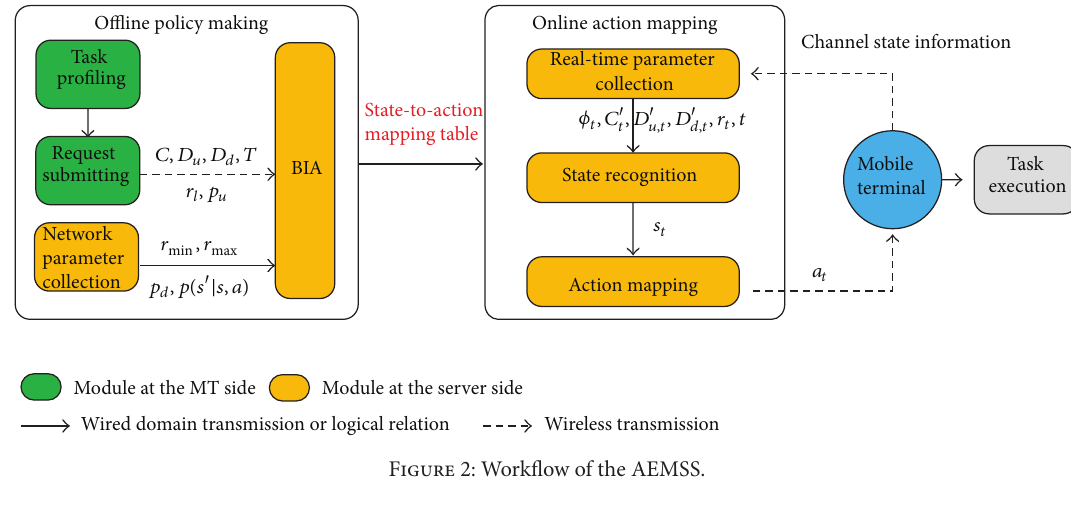
Figure 2: Workflow of the AEMSS.